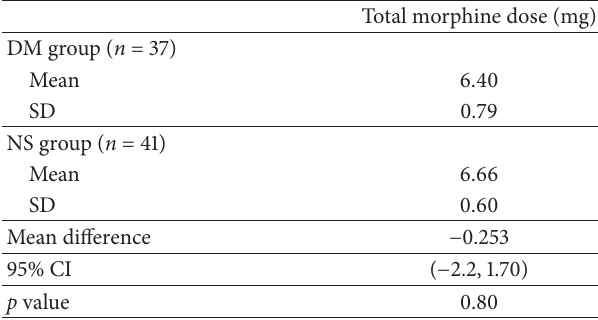
Table 3: Total morphine dose (combined intraoperative and post- operative doses).